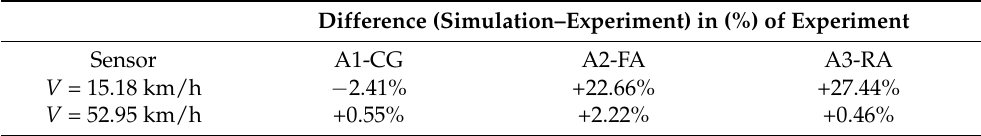
Table 8. Differences (Simulation–Experiment) of effective value RMS in